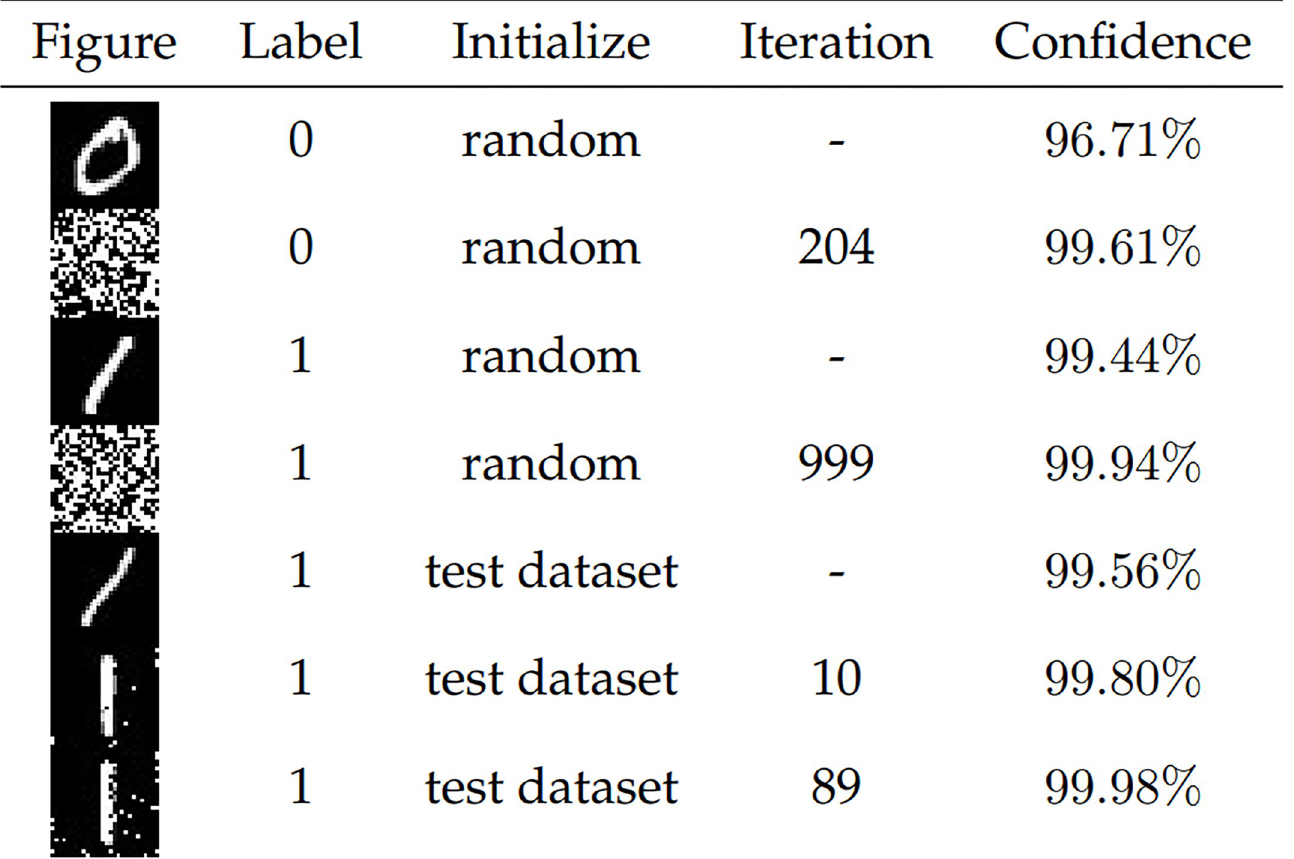
Fig 9. Statistical table of experimental